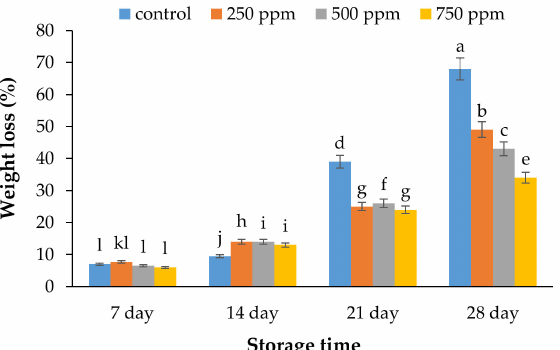
Figure 1. Effect of ACEOs on the weight loss of strawberries during storage. Different letters indicate a significant difference ( p < 0.01) between